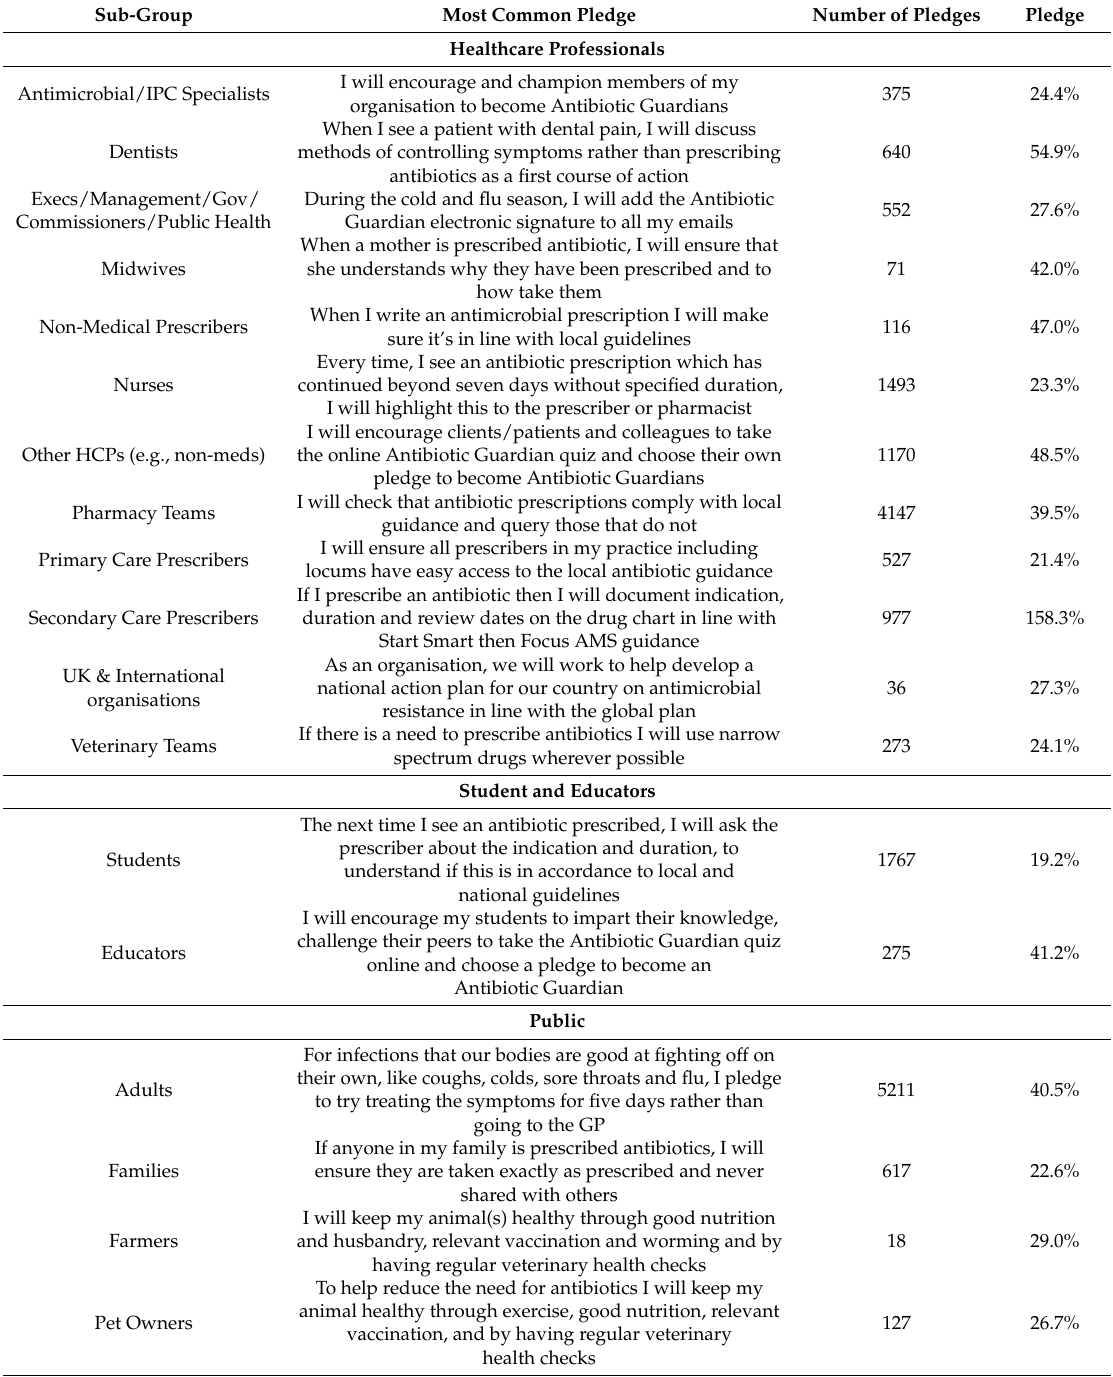
Table 3. Most common pledge by Antibiotic Guardian subgroups including number and proportion of pledges, 2014–2017.